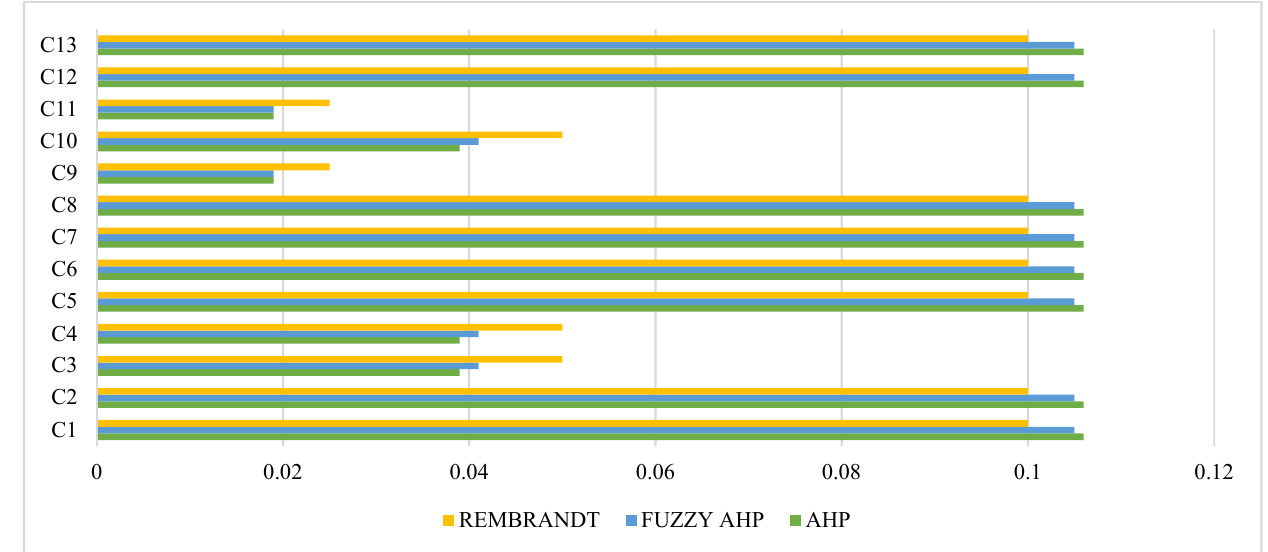
Figure 5. Decision factor weights calculated using the AHP, Fuzzy AHP, and REMBRANDT methods. Source: author’s work.